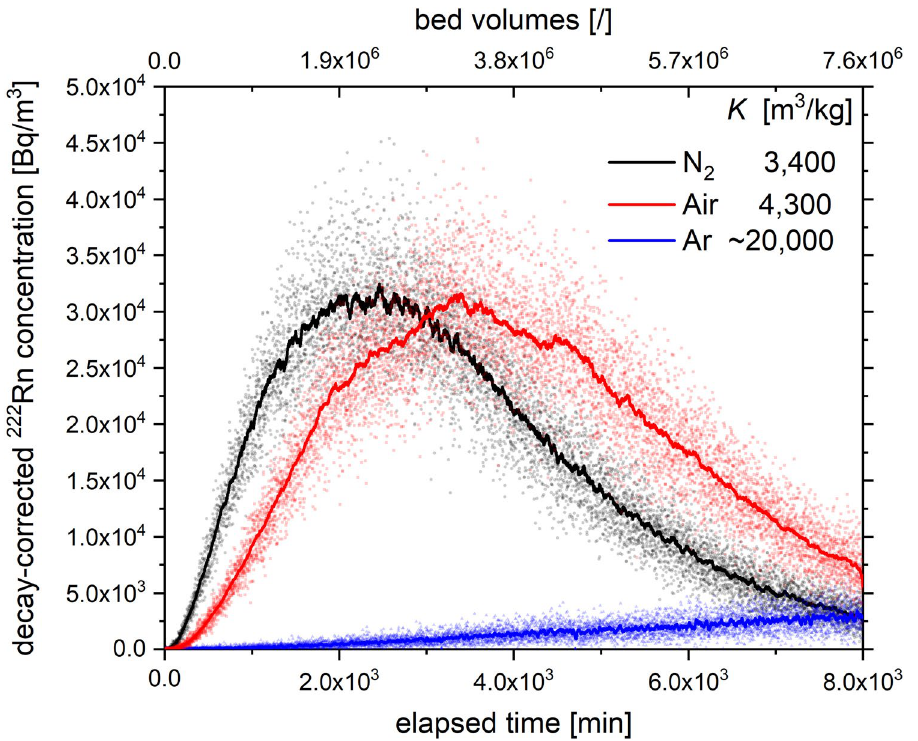
Figure 2. Decay-corrected experimental ambient temperature breakthrough curves of 222 Rn with N5.0 N 2 , compressed air and bottled N4.8 Ar as carrier gases; Ag-ETS-10 adsorbent mass 3.0 g; volumetric flow rate 3 NL/min; injected 222 Rn activity 485 kBq in each